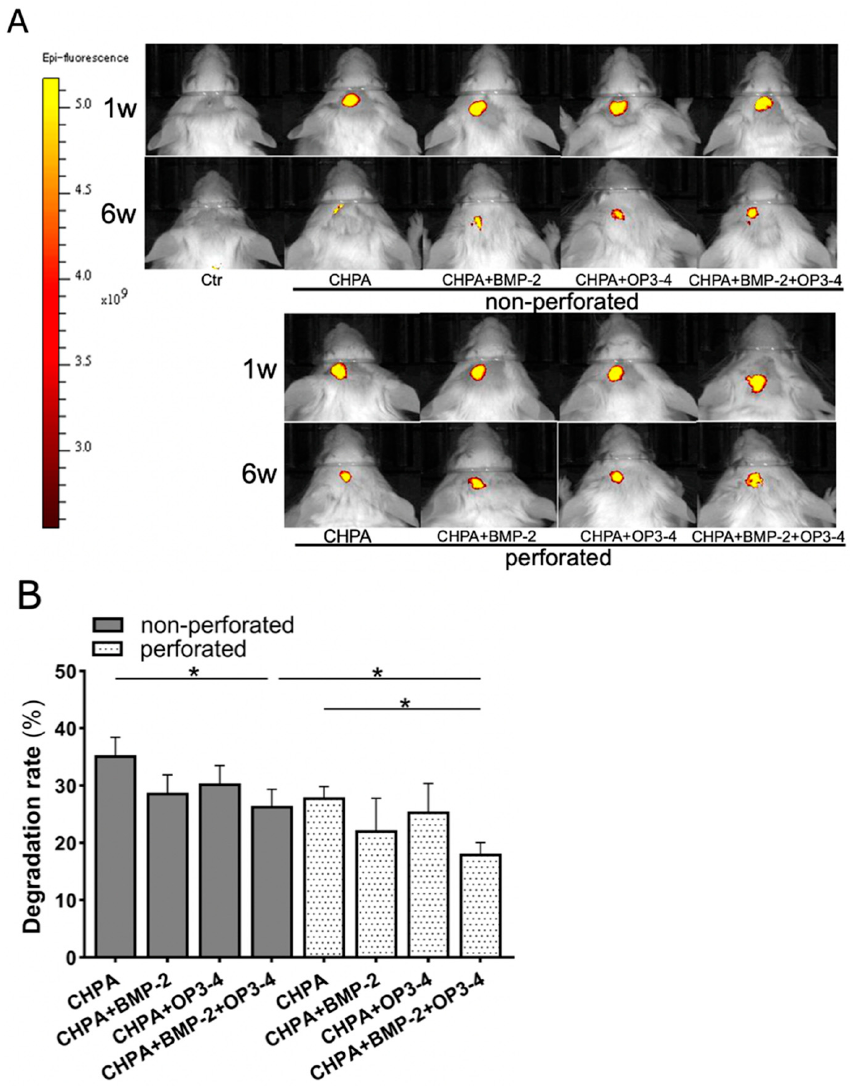
Figure 2. Perforated CHPA scaffold showed a slower degradation rate than nonperforated CHPA: ( A ) In vivo images of IVIS. Fluorescent sites and intensities of rhodamine-bound scaffold material at 1 and 6 weeks, after scaffold placement. Yellow areas in the figure represent the location and fluorescence intensity of rhodamine-bound CHPA. Excitation/absorption wavelengths: 560/620 nm; color scale: minimum 2.55 × 10 9 , maximum 5.17 × 10 9 . Ctr: control group; CHPA: Scaffold material + Vehicle; CHPA + BMP-2: Scaffold material + BMP-2; CHPA + OP3-4: Scaffold material + OP3-4; CHPA + BMP-2 + OP3-4: Scaffold material+BMP-2 + OP3-4. ( B ) Quantitative data of the degradation rate of the two differently designed scaffolds. The percentage reduction of scaffold material was calculated by taking the fluorescent area at week 1 as 100% and subtracting the fluorescent area percentage at week 6, as described in the Materials and Methods. Normality was analyzed by the Shapiro–Wilk test. Comparisons between groups were performed by the Wilcoxon rank sum test. Values are expressed as the mean ± SD, * p < 0.05.